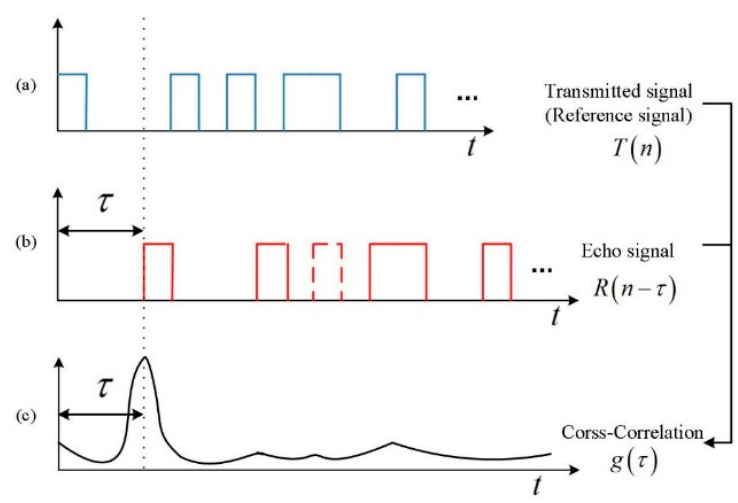
Figure 2. The schematic diagram of pseudo-random ranging principle. ( a ) The transmitted pseudo-random laser pulse sequence (reference signal); ( b ) The detected pulse sequence of the target response; ( c ) The auto-correlation function of the reference and the target response.